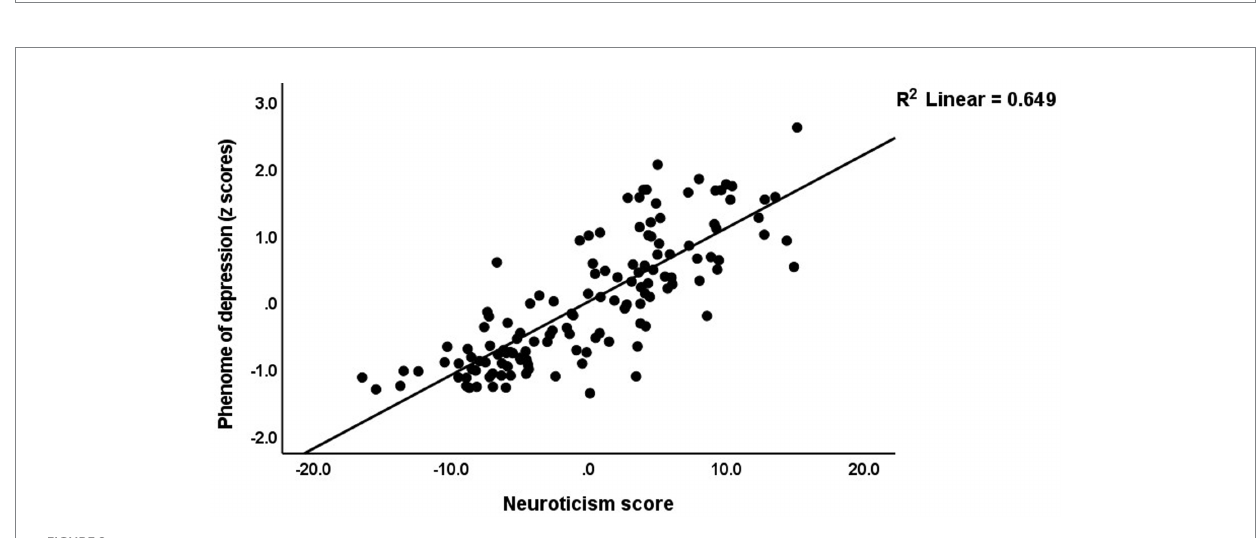
FIGURE 2 Partial regression of the phenome of depression on